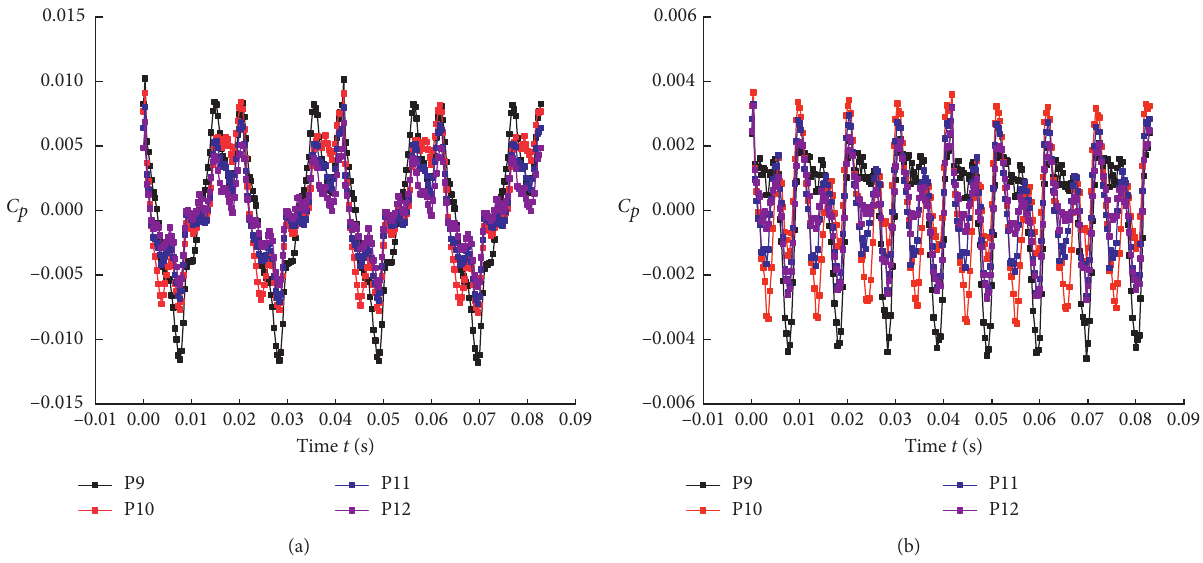
Figure 20: Time domain of each monitoring point at the guide vane outlet ( Q � Q